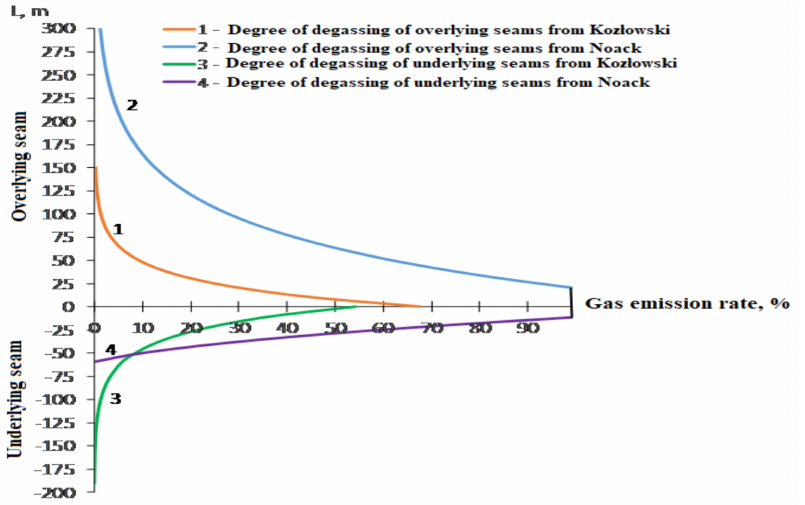
Figure 7. Degasification curve for seams affected by mining: 1,2—curves of release from coal seams in the roof; 3,4—curves of release from coal seams in the floor; 1,3—acc. to B. Kozłowski, (1982); 2 and 4 acc. to K. Noack (1998) (adapted from